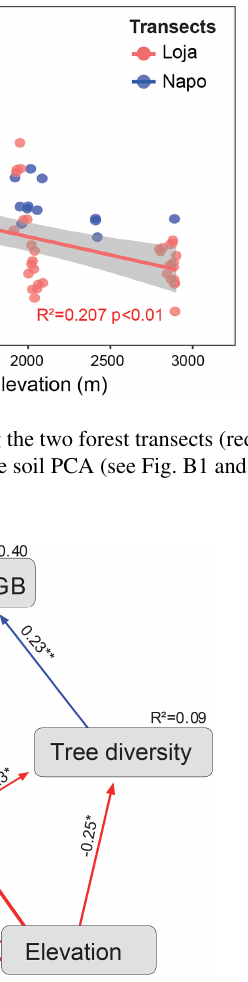
Figure 4. Final model for wood production (Loja transect and Napo transect: 83 plots). Structural equation model (chi-square = 8.4; 9 degrees of freedom; p = 0.50; AIC = 60.4; RMSEA < 0 . 01; CFI = 1.00) with standardized path coefficients. The size of the ar- rows is proportional to the strength of the paths; their significance is indicated by asterisks ( ∗ P< 0 . 05, ∗∗ P< 0 . 01, ∗∗∗ P< 0 . 001). Blue arrows indicate positive and red negative estimates. AGB: above- ground biomass; WSG: wood specific gravity; PC1, PC2: first two axes of the soil PCA (Fig. B1 and Table B1).